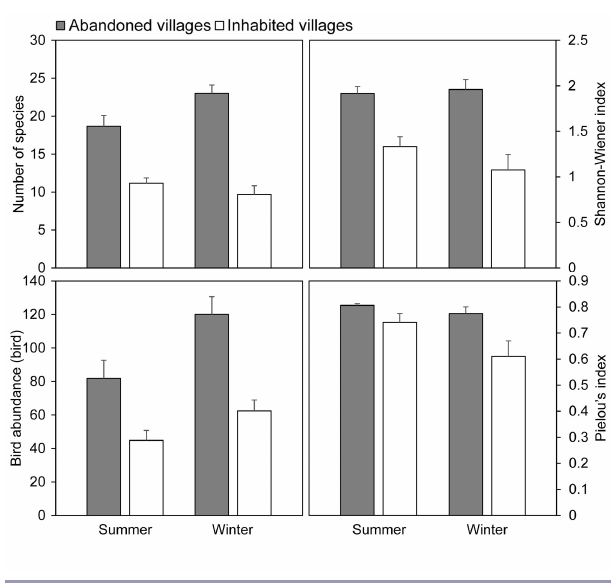
Fig. 3 . Differences in bird counts and community indices between seasons and village types in the Huaibei coal mining area of the North China